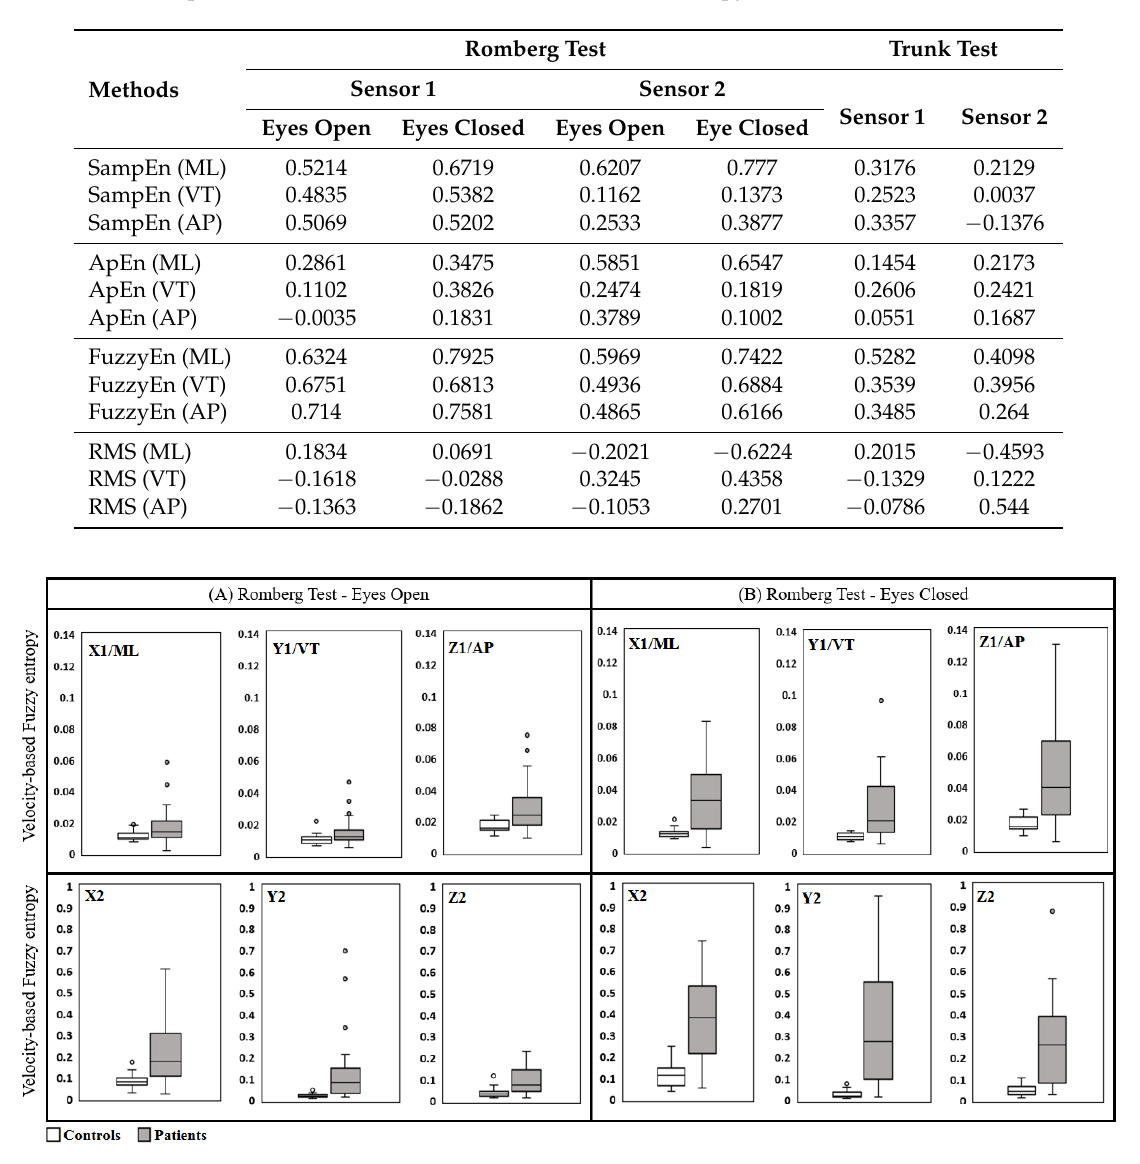
Table 1. Spearman’s rank correlation coefficients between Entropy measures and Clinical scores.